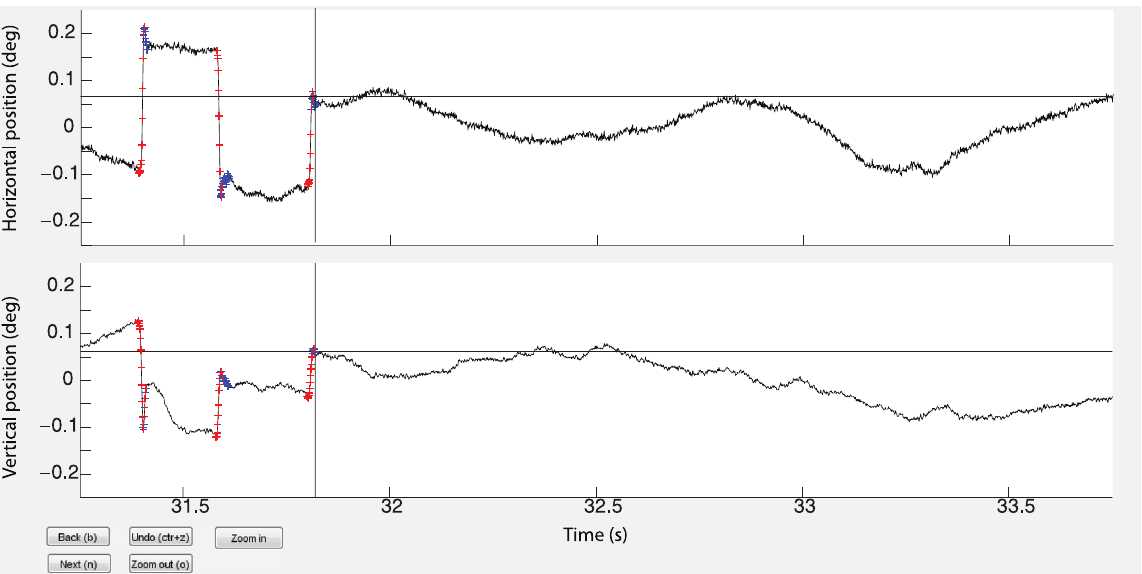
Fig 2. Microsaccade and overshoot detection. Here we show the horizontal (top black trace) and vertical (bottom black trace) EyeLink data from subject 5 over a 2.5 second epoch of time. Microsaccades were manually detected by aligning (using the mouse as control) the cross hairs, shown simultaneously on the horizontal and vertical axes, with the start of the microsaccade and clicking the mouse, and then aligning to the stop of the microsaccade and clicking the mouse. Overshoots were detected in the same way. An overshoot always began at the sample after the end of the microsaccade. The red crosses on the black traces indicate the defining samples of microsaccades and the blue crosses indicate the defining samples of the overshoots.